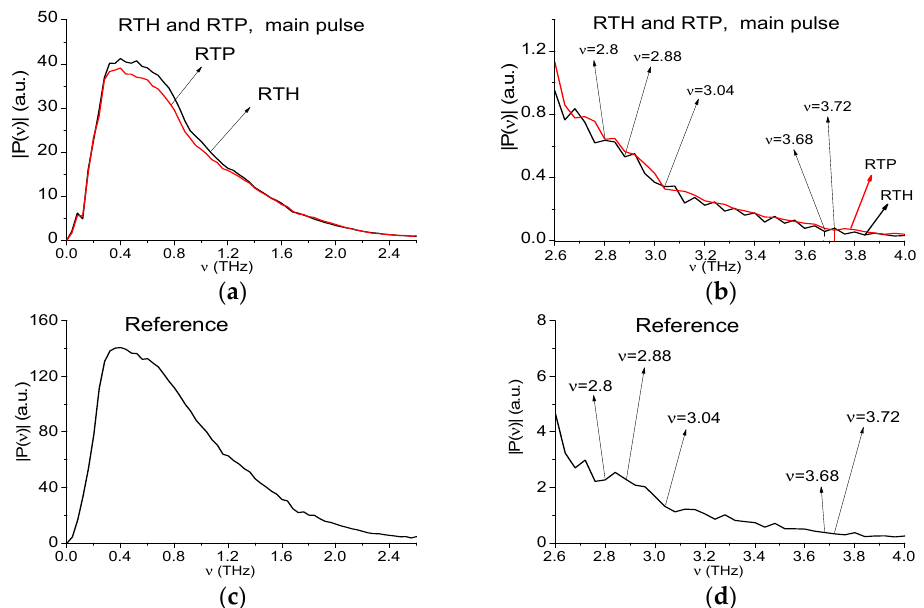
Figure 2. Spectra of the RTH, RTP main pulses ( a,b ) and reference spectrum ( c,d ) depicted in the frequency ranges ν = [0, 2.6] THz ( a,c ) and [2.6, 4.0] THz ( b,d ). The corresponding spectral resolution is equal to Δ ν = 0.04 THz.